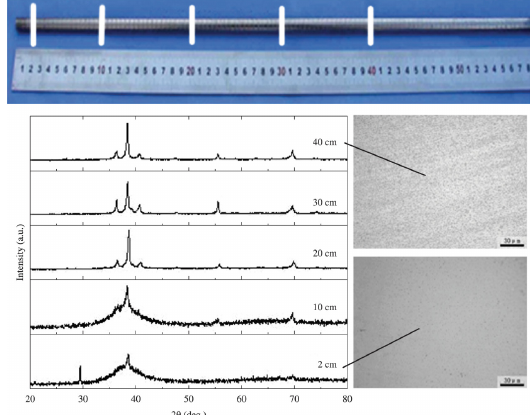
Figure 9. XRD patterns of samples from different positions of